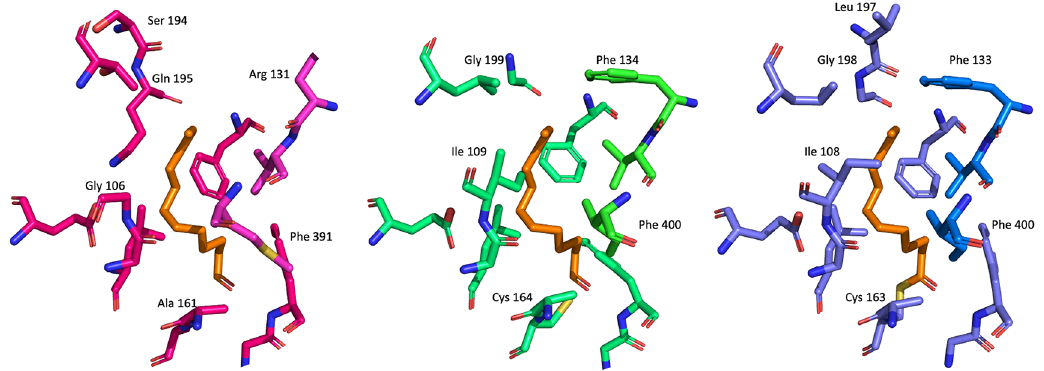
Figure 9. Comparison of the fatty acid binding channel residues of the homodimers of Pa FabF (PDB Id 4JPF), Pa FabBC161A(7PPS)and Ec FabF(2GFY). Thefattyacidbindingchannelsiteresiduesofthethreedifferentenzymes are shown as blue/light blue, green/light green and magenta/light magenta sticks, respectively. C12 fatty acid binding to Ec FabF is superimposed with the remaining structures and shown as orange